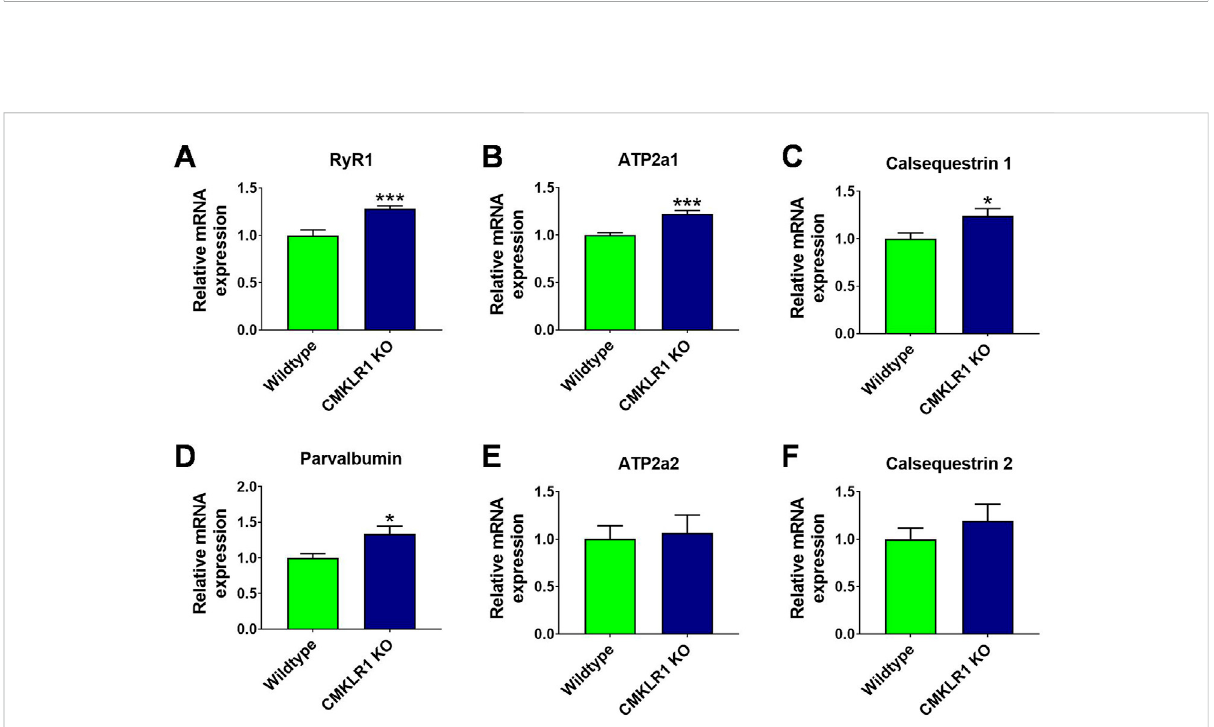
FIGURE 4 Abrogating signaling through CMKLR1 induces expression patterns characteristic of fast-twitch muscles Relative mRNA levels of genes governing rapid calcium release and uptake measured in mouse gastrocnemius complex of wild type and CmklR1 KO mice: Ryanodine receptor for calcium release (A) , SERCA1 for calcium reuptake (B) , calsequestrin 1 (C) and parvalbumin (D) for calcium storage and buffering. SERCA2 (E) and calsequestrin2 (F) aretheprevalentisoformsin fi berswithslowcalciumturnover.Valuesareexpressedasmeans±SEM;*: p < 0.05,**: p < 0.01, ***: p < 0.001 versus wild type mice by unpaired t -test; n = 9 – 10 per group.